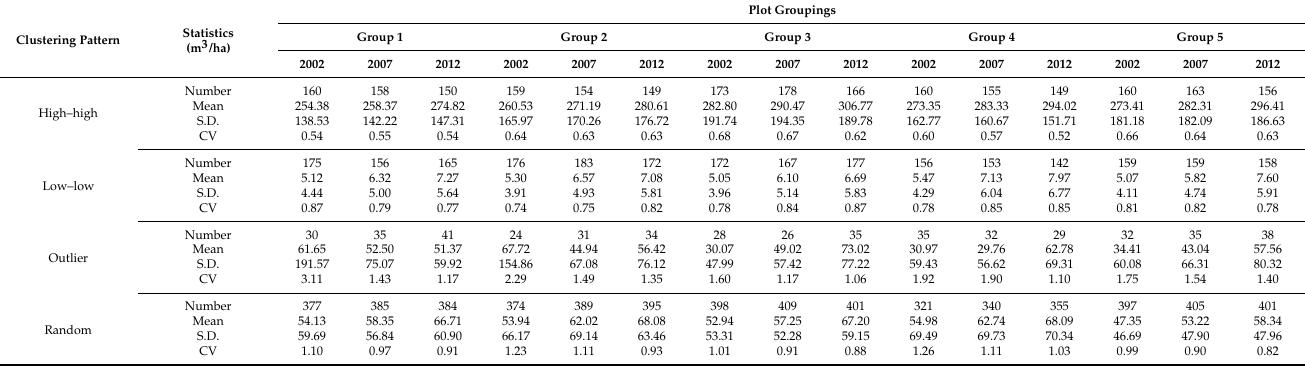
Table 2. Estimation results of the forest volume by systematic sampling in the second stage.